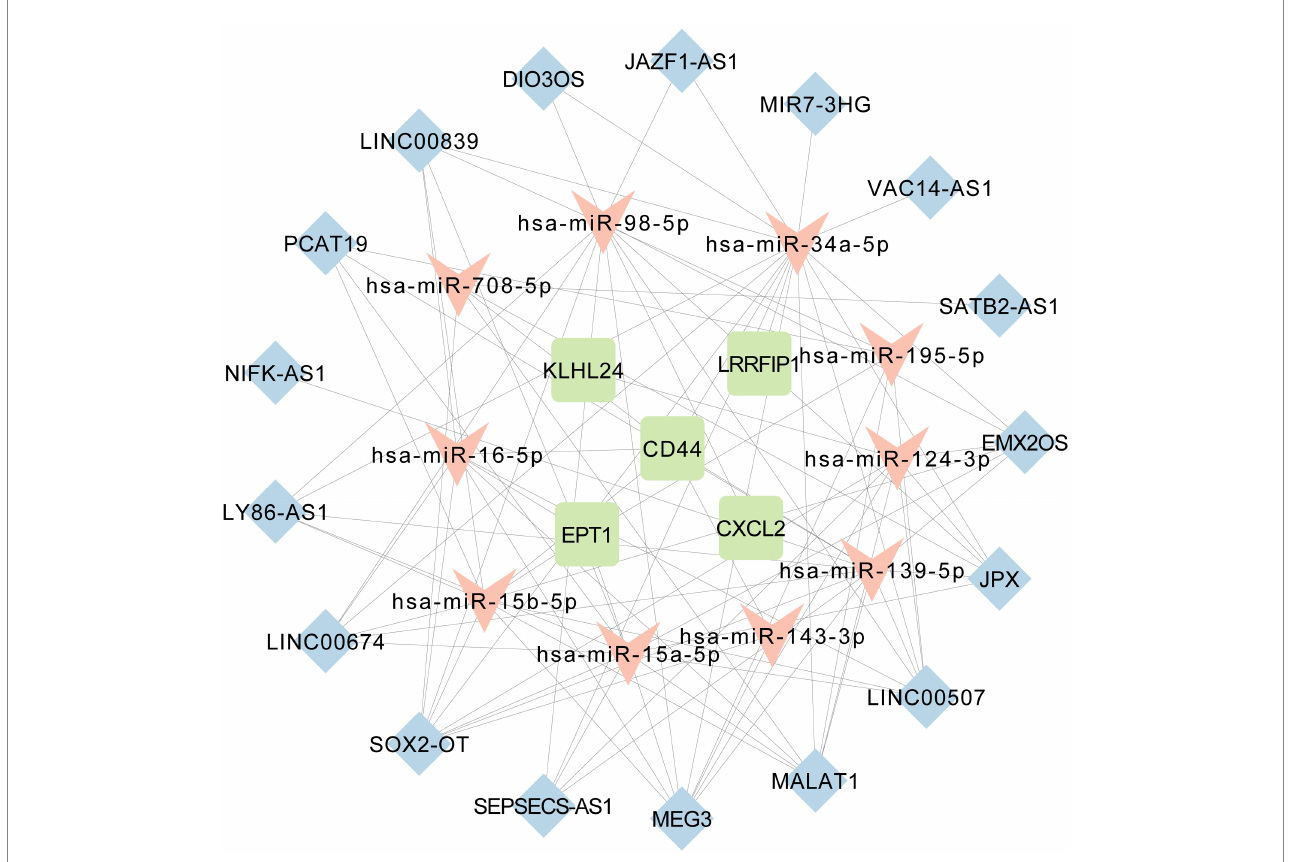
FIGURE 6 The long non-coding RNA-associated competing endogenous RNA (ceRNA) network of 17 lncRNAs, 10 miRNAs and five ferroptosis-related